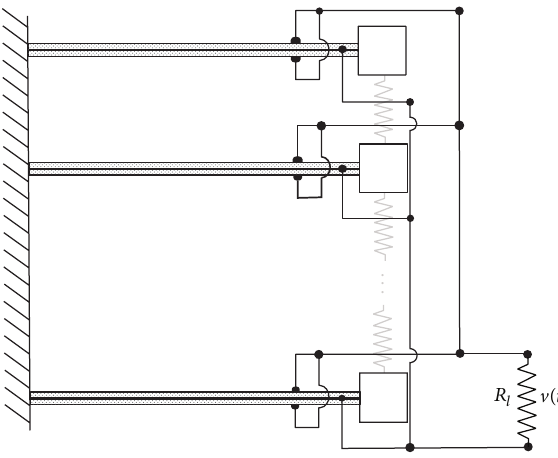
Figure 5: A parallel electrical connection of an array of bimorph beams connected by